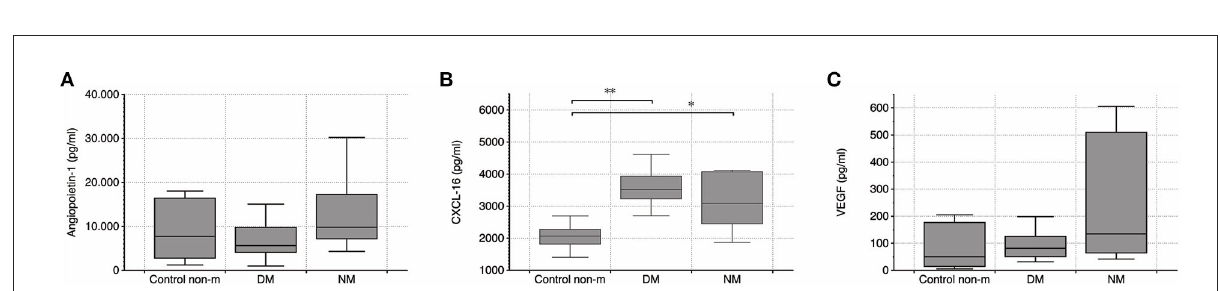
FIGURE4 (A–C) Quantification of serum Ang-1, CXCL16, and VEGF by ELISA. Systemic VEGF level did not differ between any of the groups, but CXCL16 was elevated in DM and NM, respectively. Further differences were not detected. The following numbers of samples were analyzed per group: Control non-m: n = 11; DM: n = 14; NM: n = 6 (Control non-m: non-myopathic control; * and ** , p-values < 0.05).